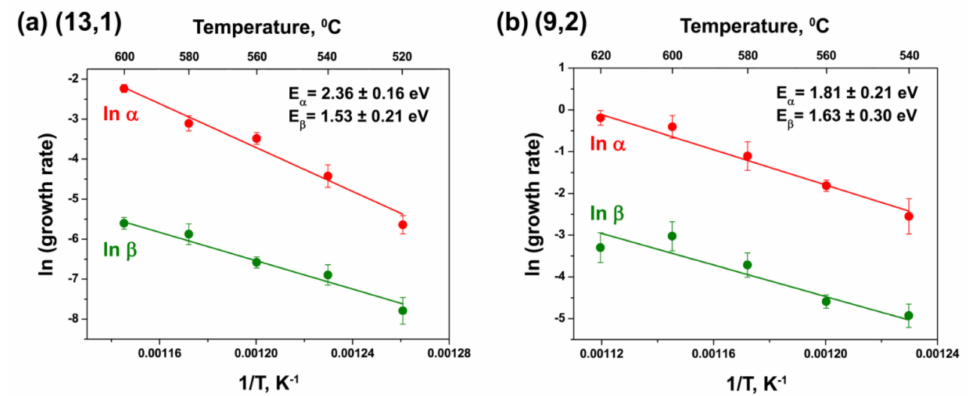
Figure 14. The plots of natural logarithms of the growth rates α and β versus inverse annealing temperature for the inner tubes with chiralities of (13,1) ( a ) and (9,2) ( b ) formed upon in situ annealing of the NiCp 2 − and CoCp 2 − filled SWCNTs, respectively. The top abscissa axis shows the annealing temperature in Celsius degrees for convenience. The calculated activation energies E α and E β are indicated together with their